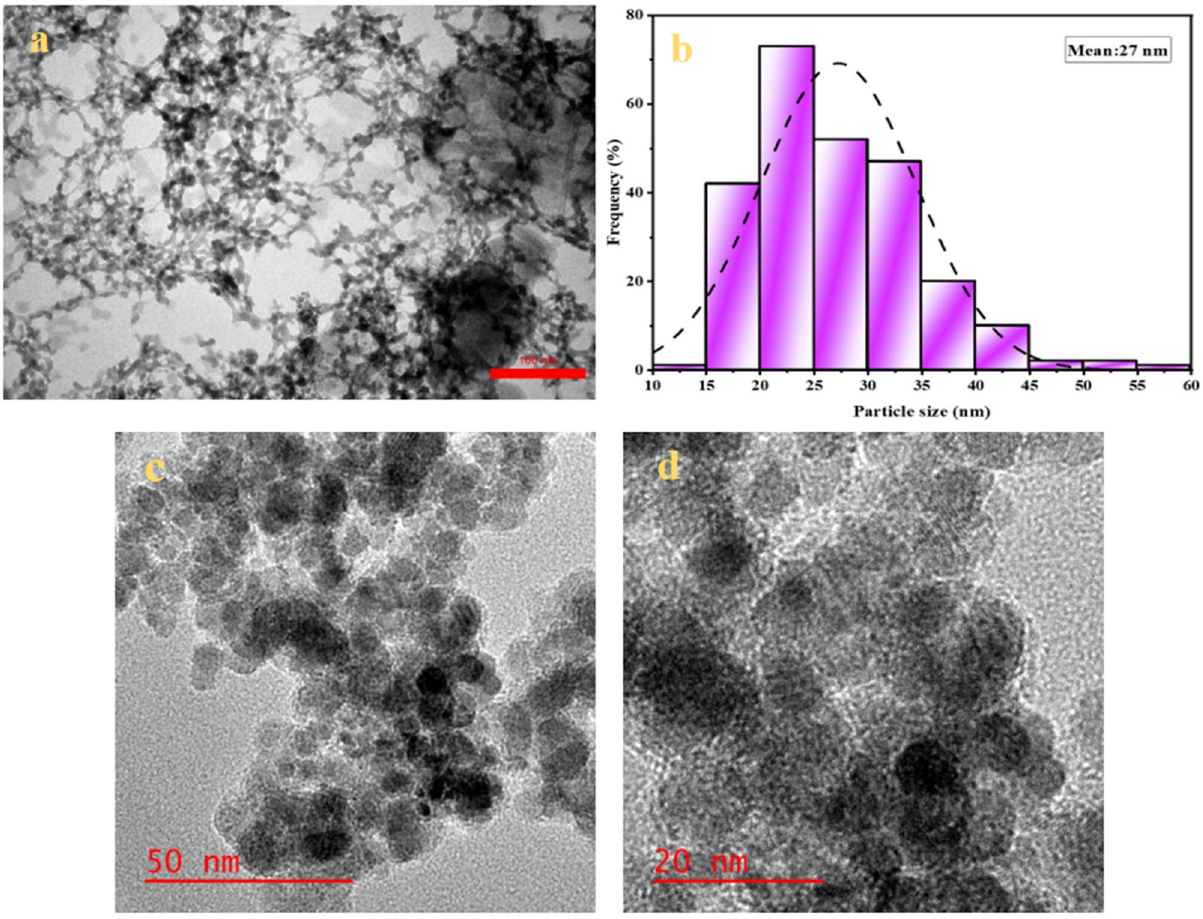
Figure 5. TEM ( a ), HRTEM ( c & d ), and particle size distribution histogram ( b ) of synthesized Fe-Ben/PVP- DVB/Pd